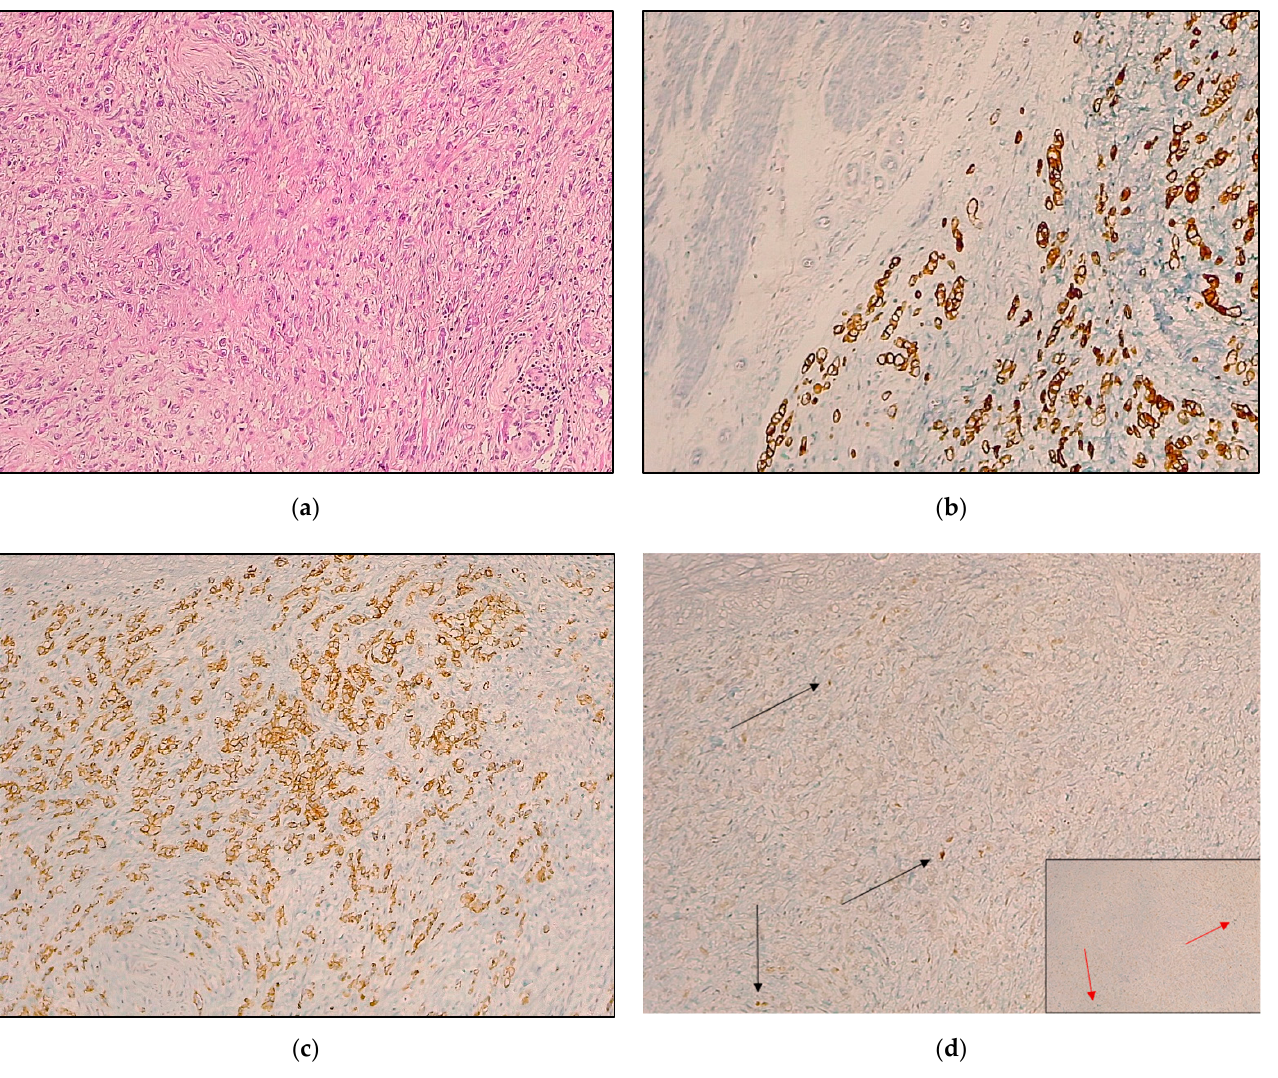
Figure 2. Representative sample of negativity for epithelial-to-mesenchymal transition markers: ( a ) A poorly cohesive other cell type (WHO) or diffuse type (Lauren) is presented; ( b ) a 8/18 cytokeratin stain confirming the epithelial origin of the neoplastic proliferation is shown; ( c ) E-cadherin positivity of neoplastic cells is depicted; ( d ) neoplastic cells do not show positivity for CD44 and Zeb-1 (inset, bottom right); the positive control is represented by lymphocytes (arrows). ( a ) Hematoxylin and eosin; ( b ) CK8/18 stain; ( c ) E-cadherin stain; ( d ) CD44 stain; inset on the bottom right, Zeb-1 stain. Original magnification (OM): a–d , 4×; d, inset, 10×.